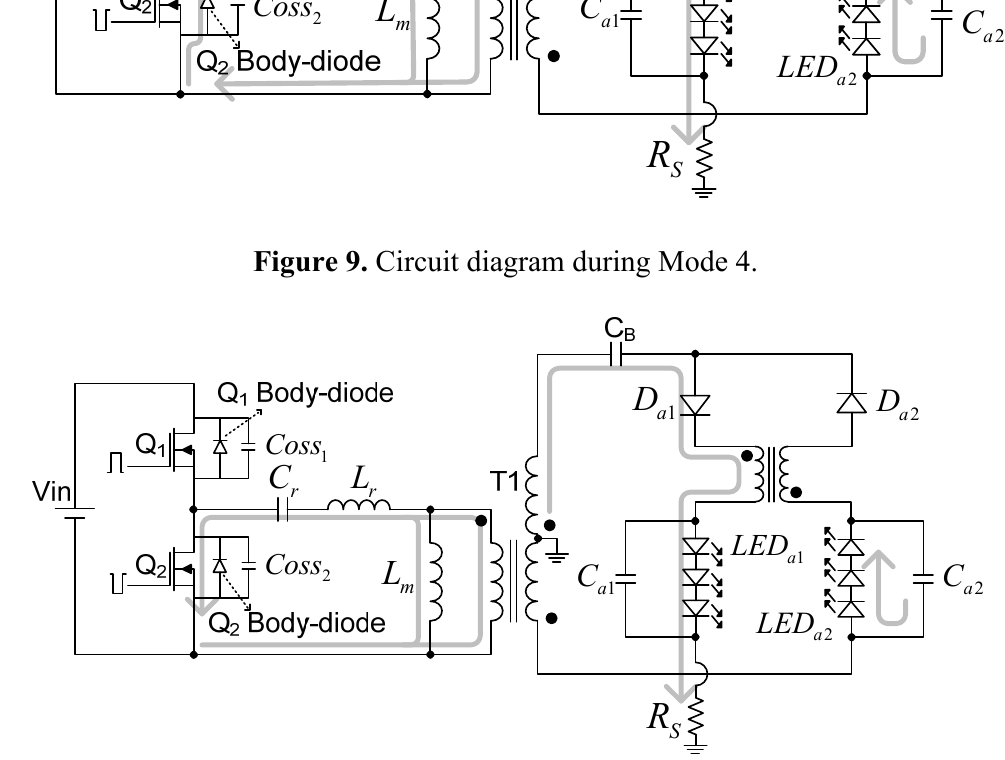
Figure 10. Circuit diagram during Mode 5.